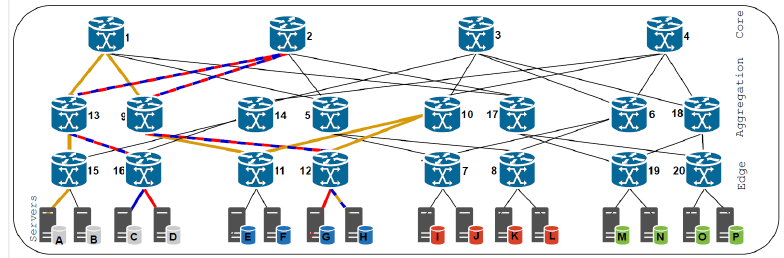
Figure 1. Motivational example of the FPLF algorithm’s behavior.